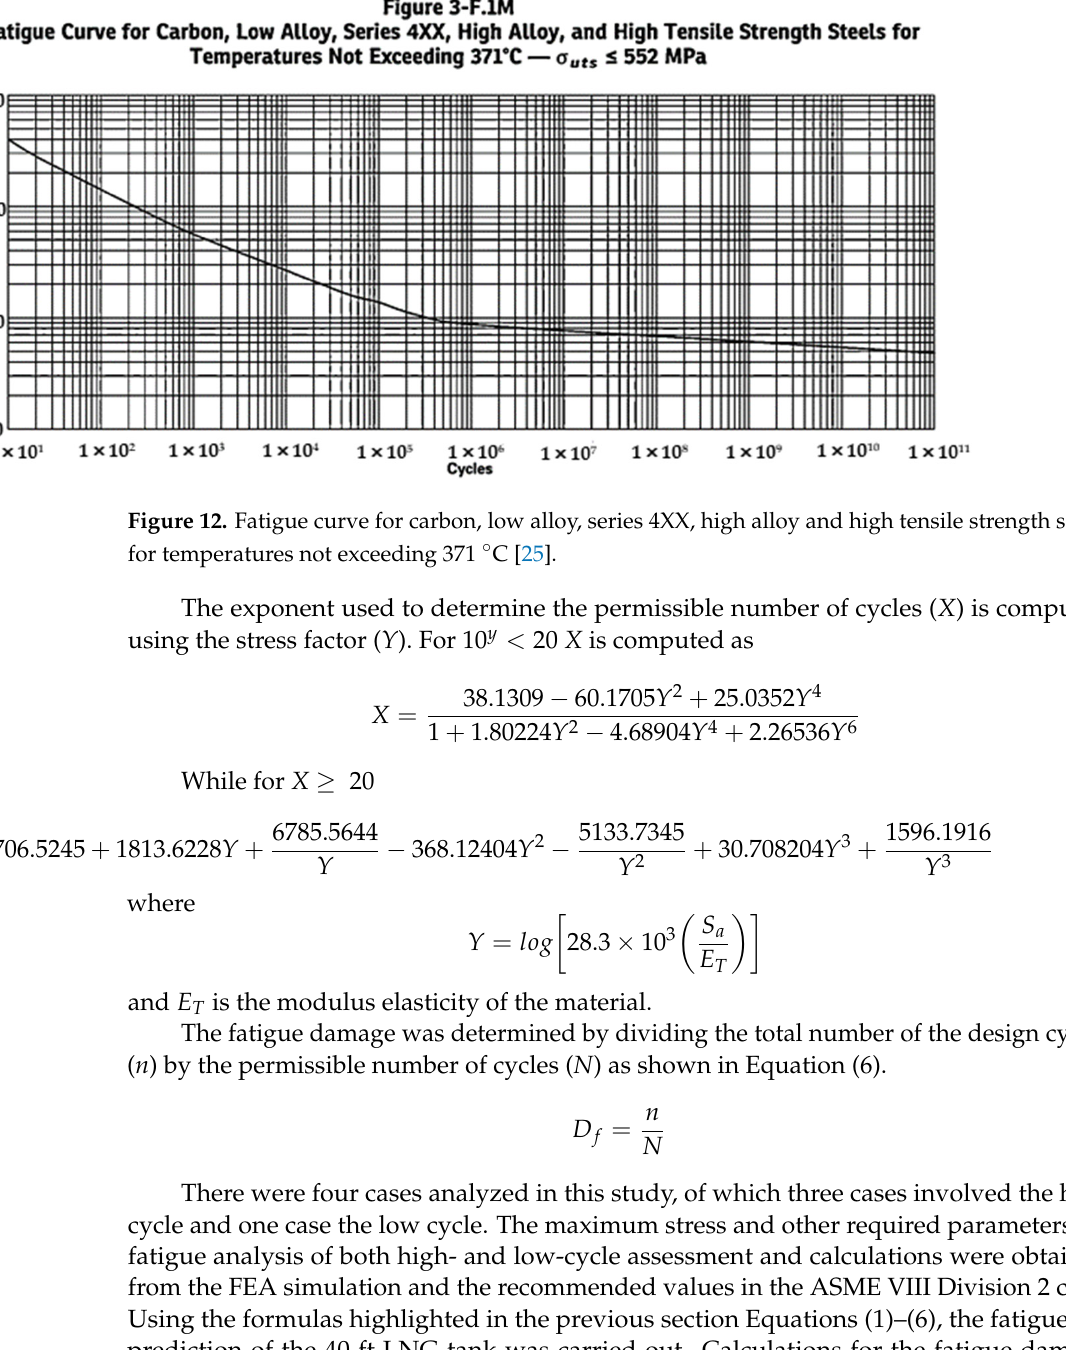
Table 4. Results for the finite element analysis. Parameter